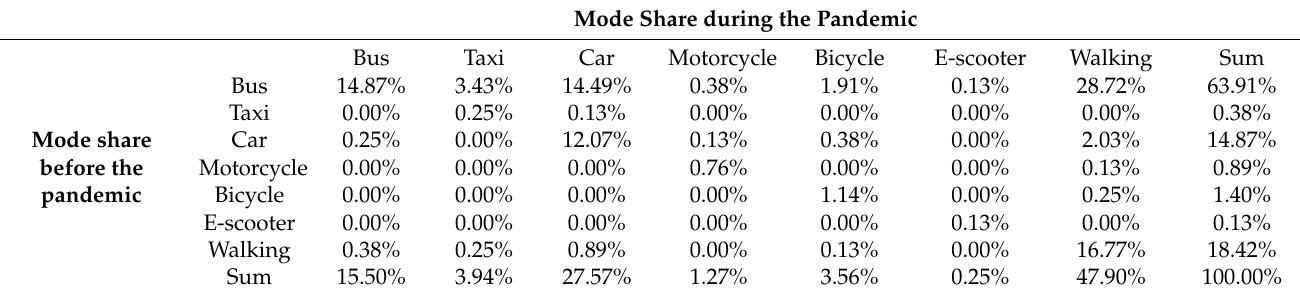
Table 1. Cross-tabulation of mode shares among the survey respondents before and during the pandemic. Mode Share during the Pandemic